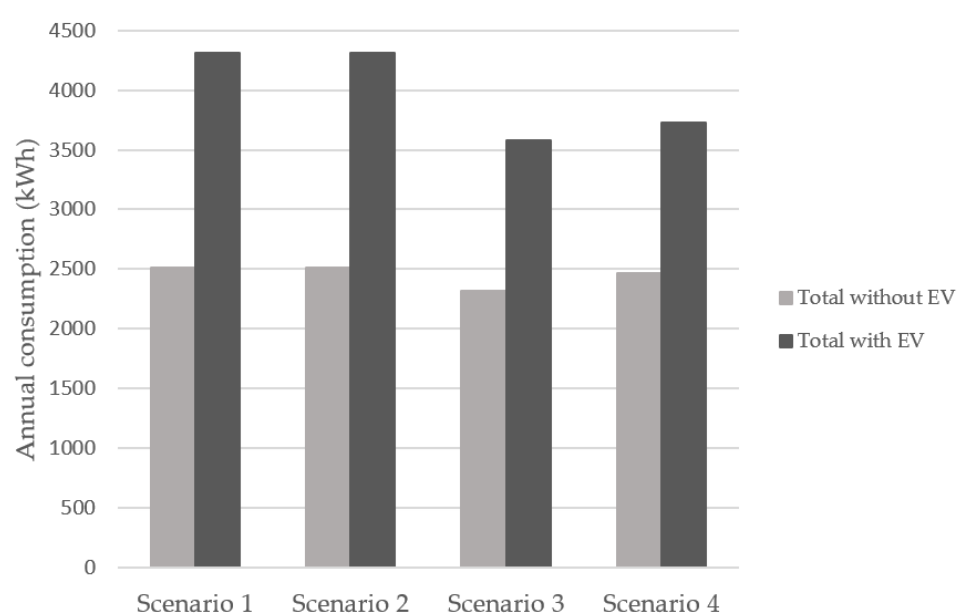
Figure 13. Efficiency comparison evaluating the impact of EV considering the AC/DC possibilities presented in Table 2.